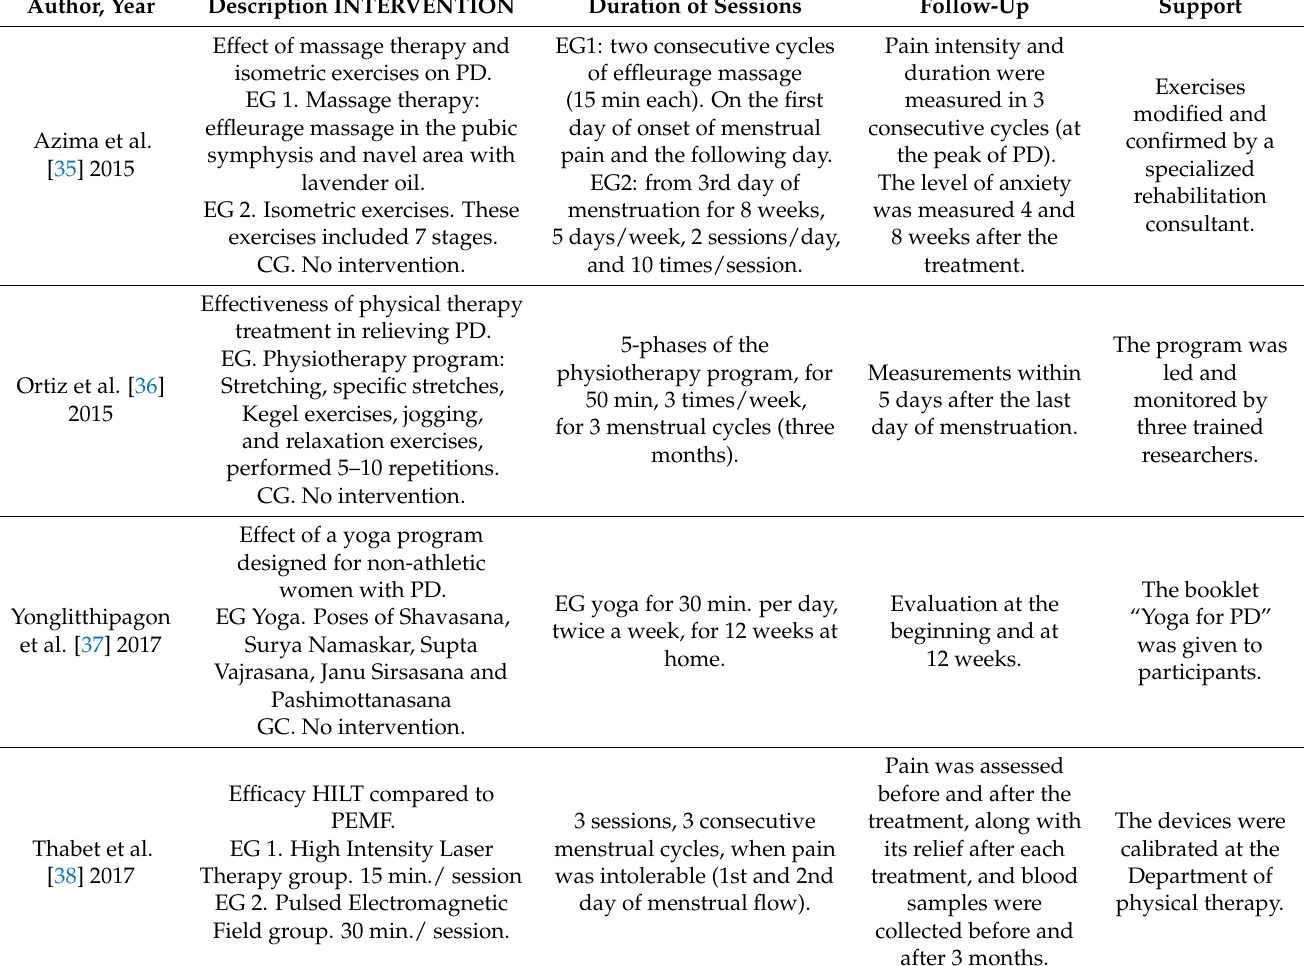
Table 3. Characteristics of the intervention of the selected